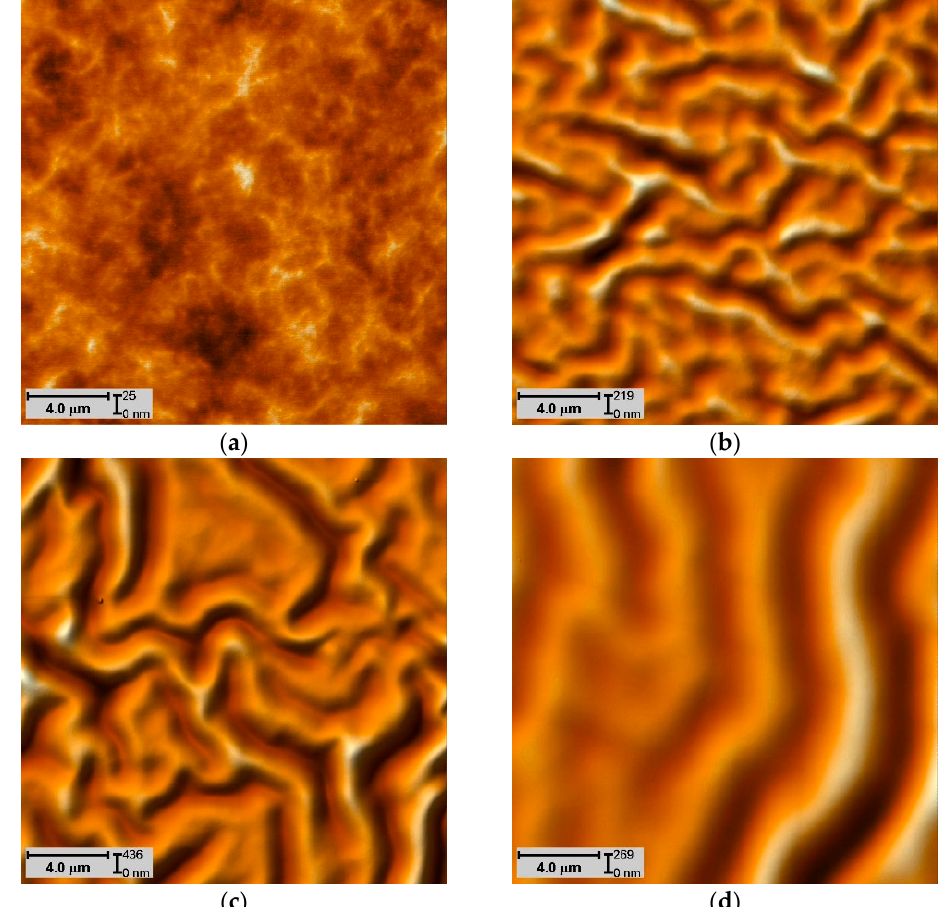
Figure 9. Topography of a 20 × 20 μ m region on the surface of untreated polyurethane ( a ) and treated with 5 × 10 14 ion/cm 2 ( b ), 10 15 ion/ cm 2 ( c ), and 5 × 10 15 ion/ cm 2 ( d ).